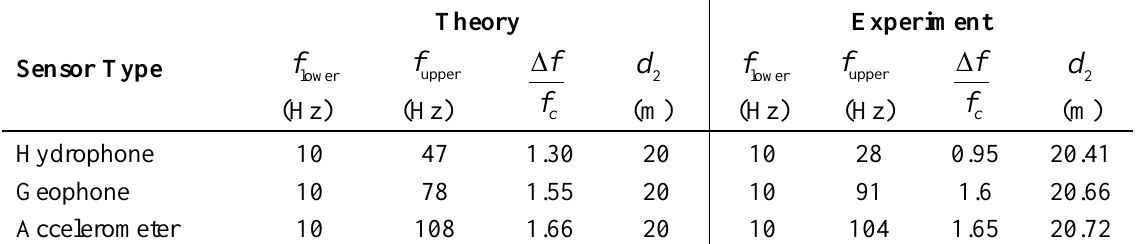
Table 3. Key parameters determined from the leak data (theory and experiment (strong